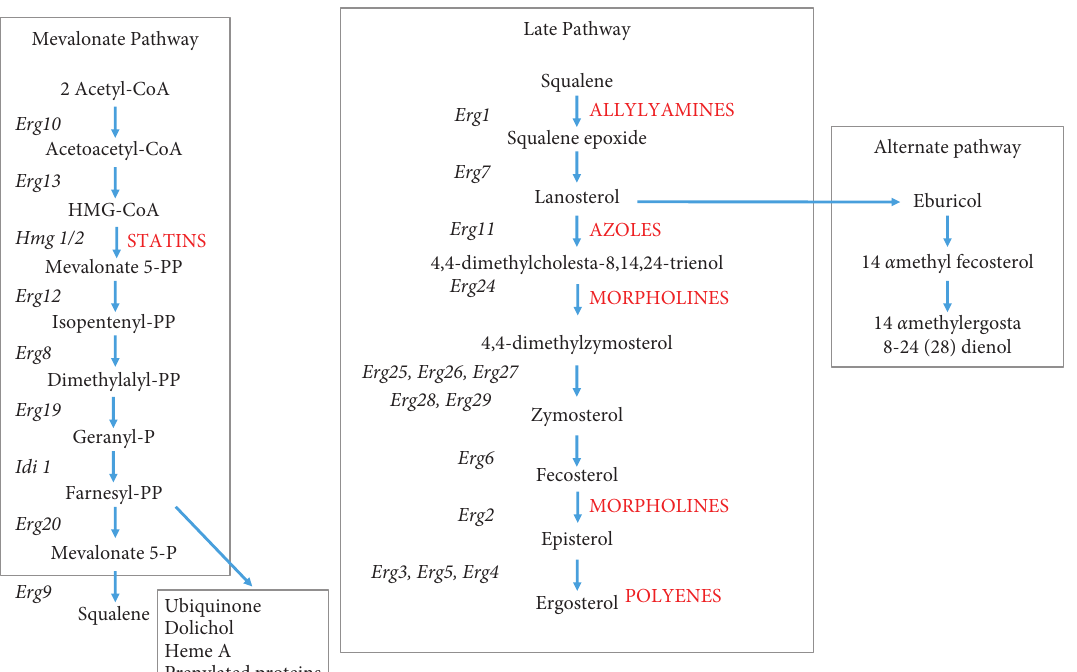
Figure 12: The ergosterol biosynthetic pathway. The pathway has been divided into three subpathways, the mevalonate pathway, the late pathway, and the alternative pathway, which can occur in the event of inactivation of lanosterol metabolizing enzymes. Shown in red are some common types of antifungal drugs at their site of action within this pathway adopted from